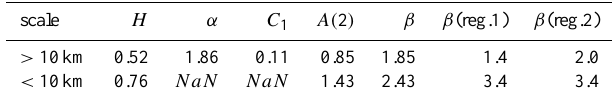
Figure 3. Theoretical structure function ζ(q) combining the 21 lin- ear fits shown over Fig. 2. Red points (or blue points) correspond to the range of scales larger (or smaller) than 10km. Table 1. Estimates of the fractal and multifractal parameters for scales below and above 10km. The last two columns were taken from Aharonson et al. (2001). Region 1 is a heavily cratered south- ern terrain. Region 2 is an area in the northern